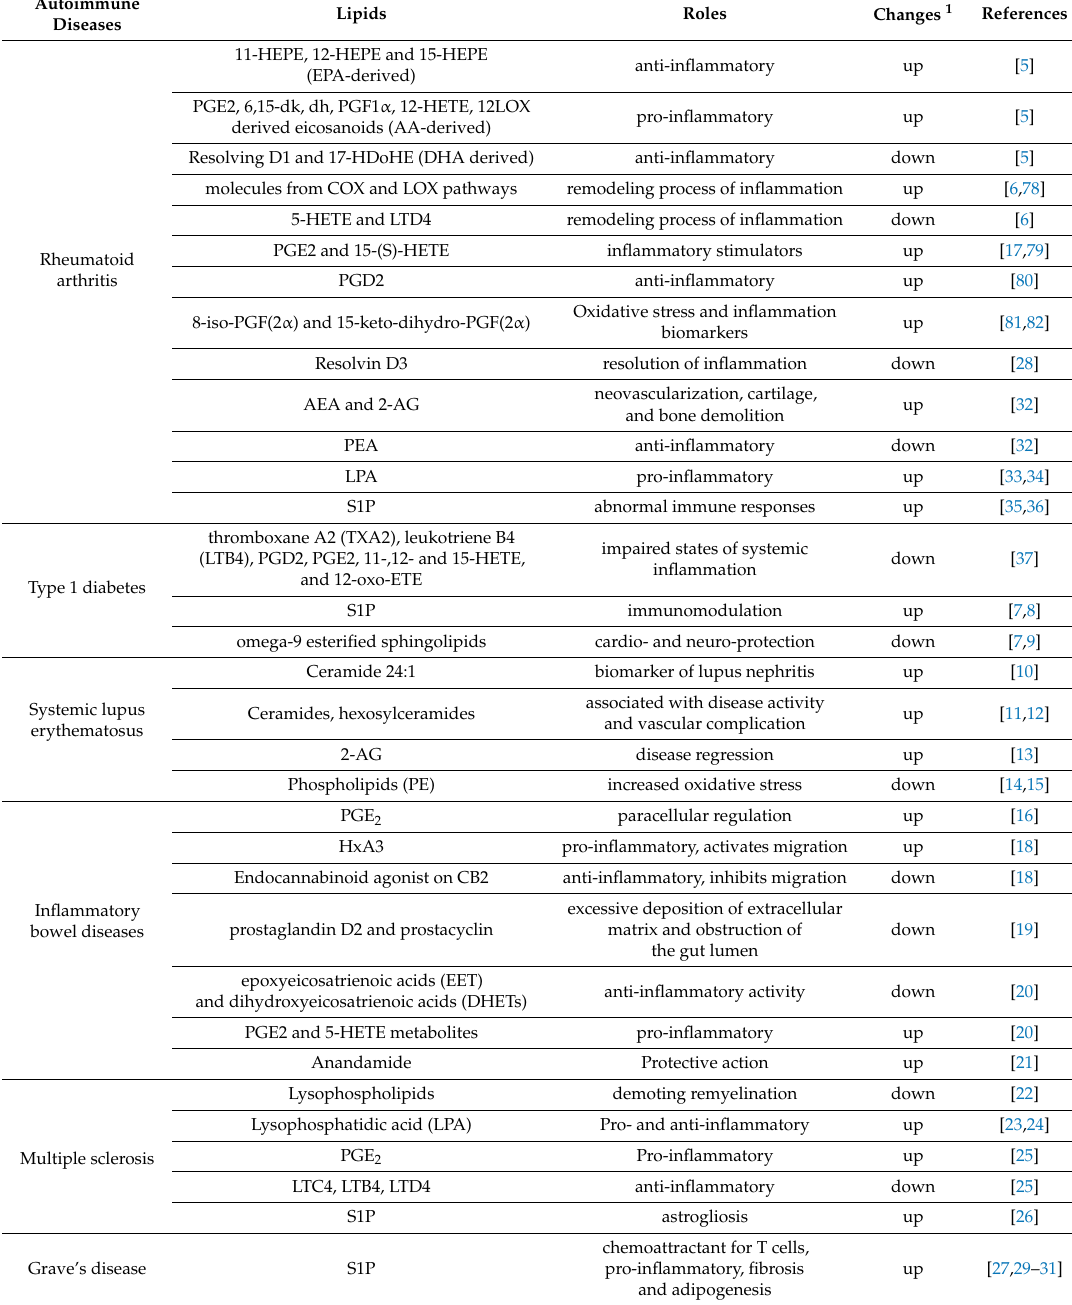
Table 1. Functional lipids and their corresponding role in autoimmune